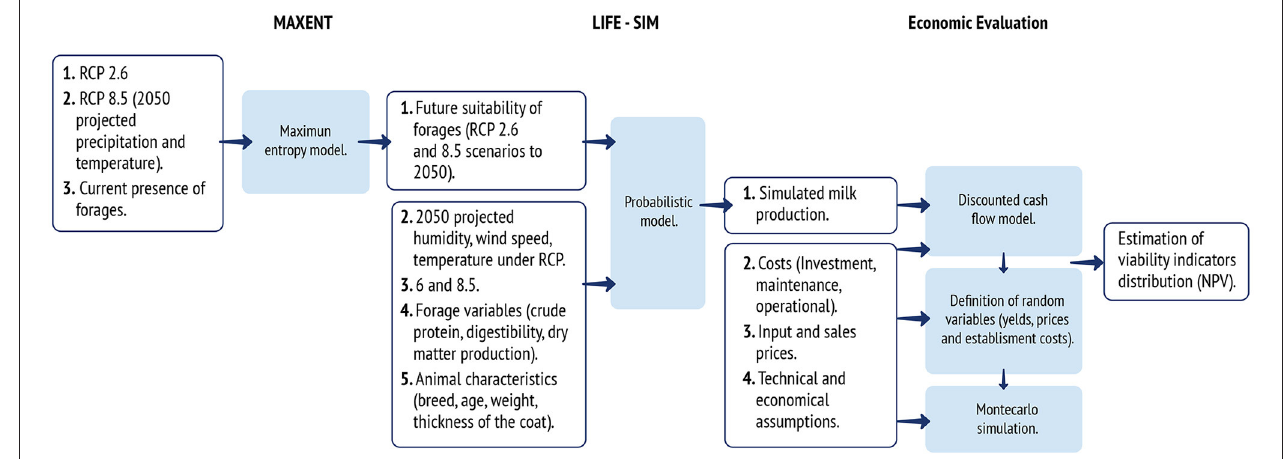
FIGURE 2 | Interdependence of the models used in this study (Maxent, Life-Sim, and economic